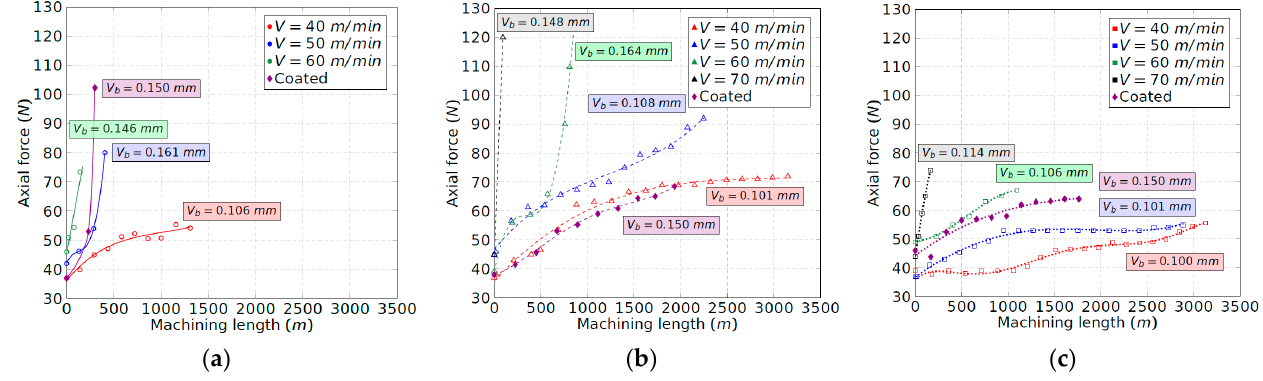
Figure 10. Axial force evolution vs. machining length: ( a ) tool configuration 1; ( b ) tool configuration 2; and ( c ) tool configuration 3.